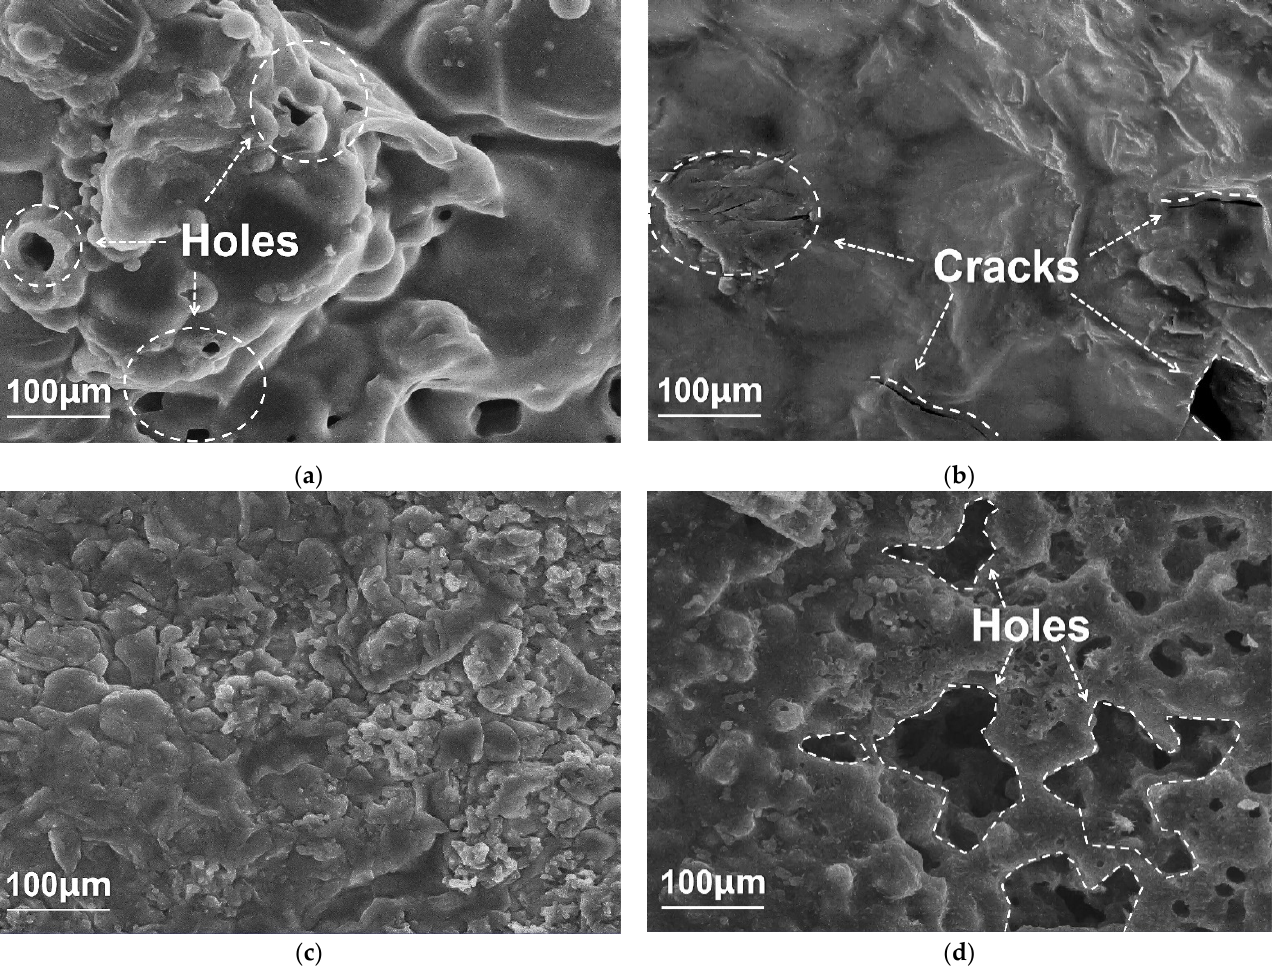
Figure 6. The scanning electron microscopy (SEM) photos of the residue chars of ( a ) PLA/B15, ( b ) PLA/M5, ( c ) PLA/M5B15, and ( d ) PLA/B20.